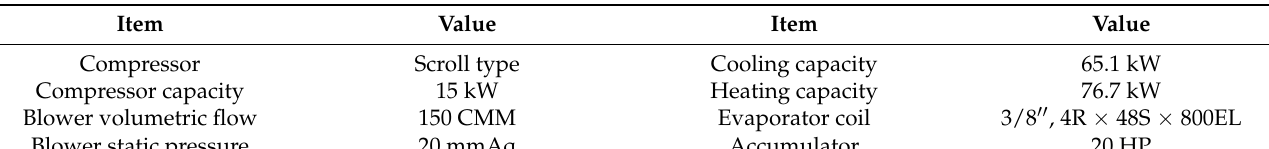
Table 3. Specifications of the 20 RT (70 kW) air conditioner.